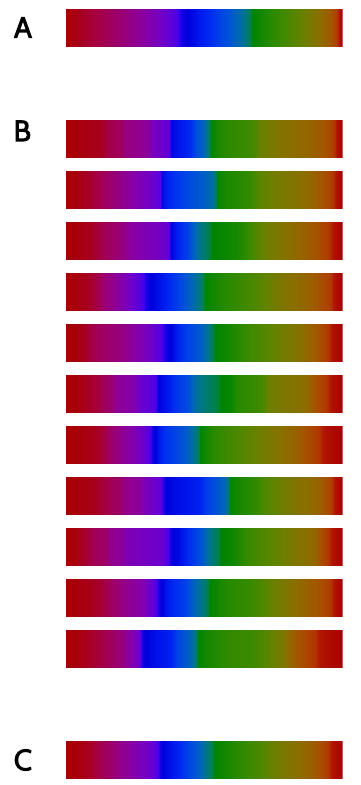
Fig 8. A mnemonically uniform color scale. Comparison between the original color scale t used in the game (A) with the new uniform color scales s designed for each player (B). C: uniform color scale obtained with the sample average of J ( t